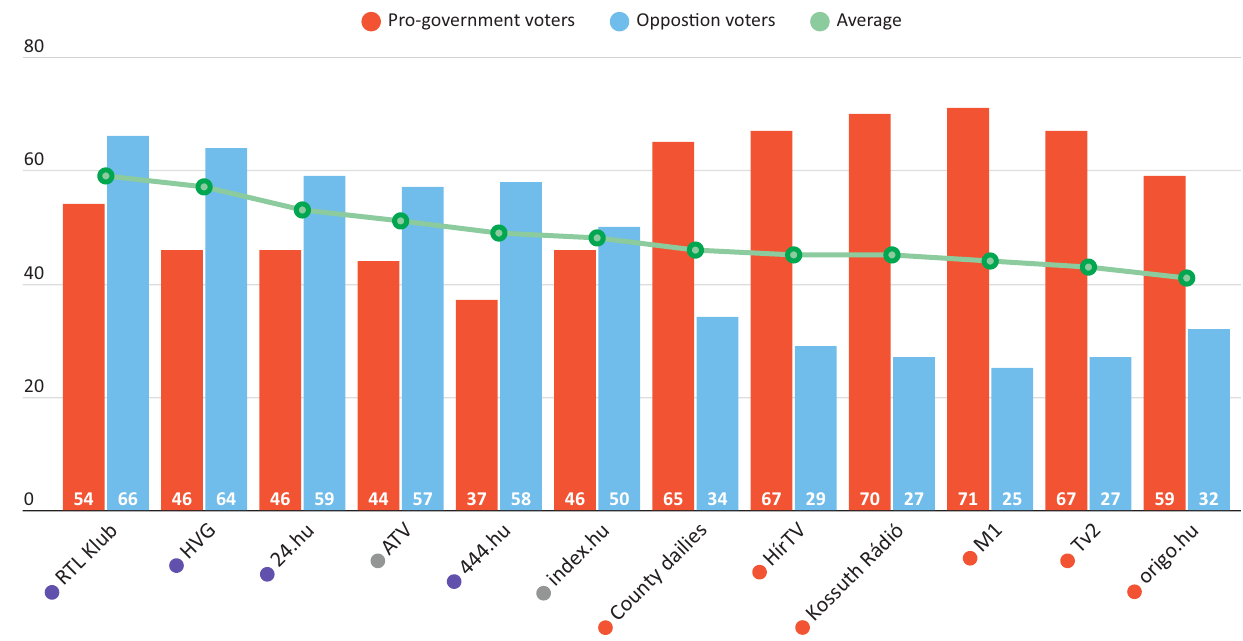
Figure 4. Perception of credibility of news sources by party preference (2020). Note: Averages on a scale of 0 to 100. Zakaria (1997, p. 22), who distinguished “democracy” from “constitutional liberalism.” Democracy can be nar‐ rowly defined as no more than “competitive, multiparty elections” (Zakaria, 1997, p. 43); constitutional liberal‐ ism, however, was developed “as a defence of the indi‐ vidual’s right to life and property, and freedom of religion and speech” (Zakaria, 1997, p.